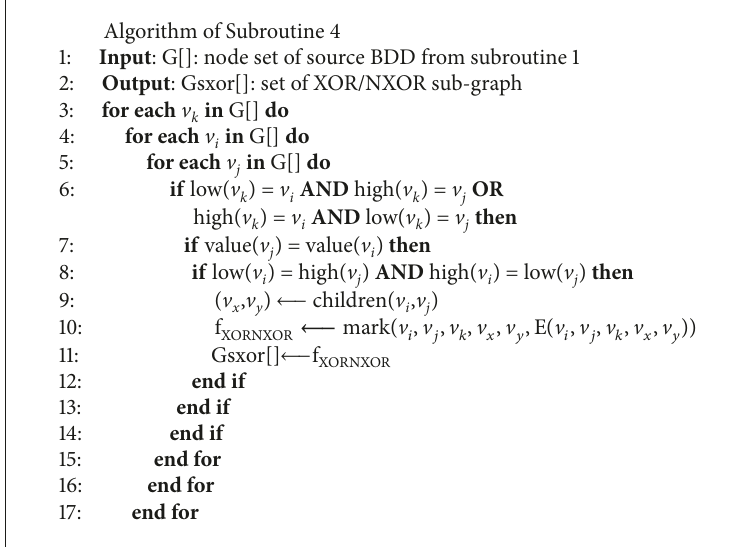
Algorithm 4: The algorithm of subroutine 4 in the BDD-based extraction